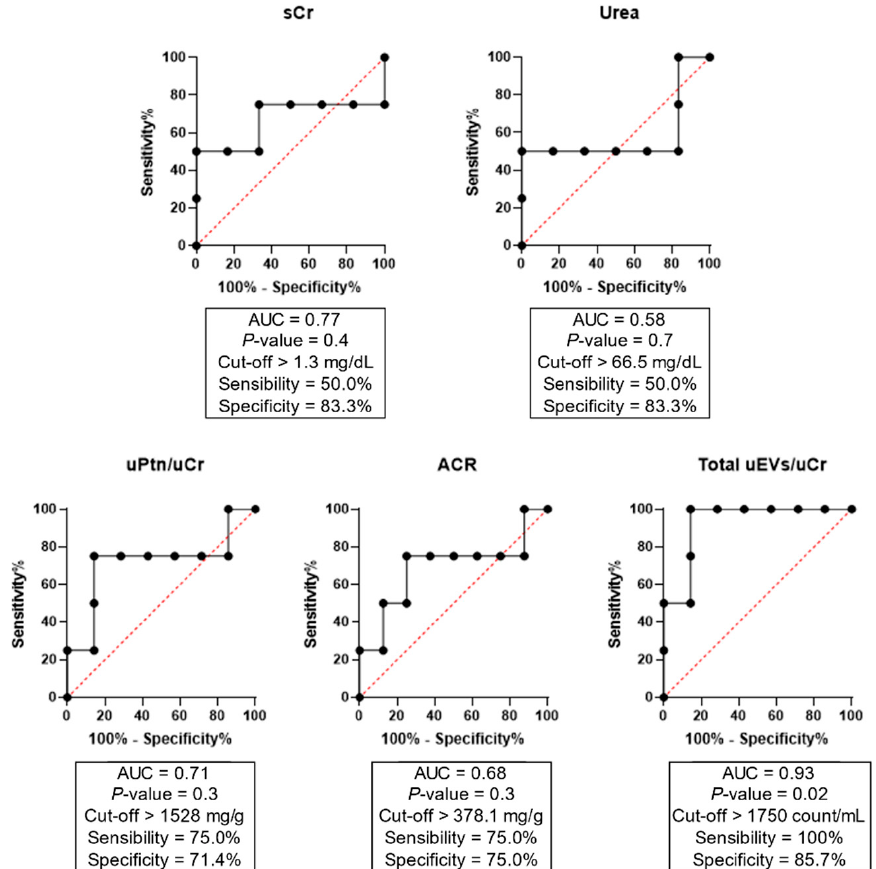
Figure 2. ROC curves of total uEVs, proteinuria, and albuminuria for the prediction of hemodialysis as a clinical outcome in COVID-19 severe/critical patients. ACR = albumin-to-creatinine ratio; AUC = area under the curve; Cr = creatinine; Ptn = protein; u = urinary.